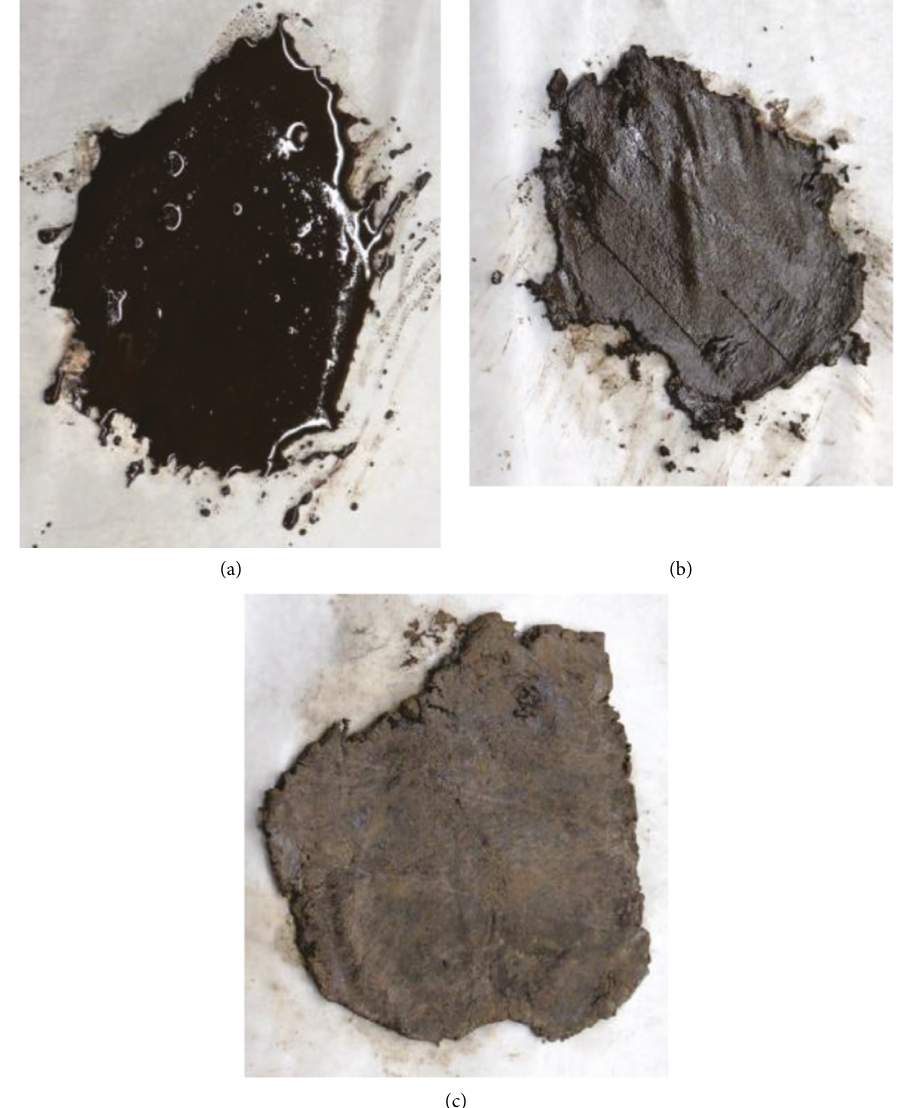
Figure 2: Evaluation of the filler concentration. (a) 20% filler content. (b) 50% filler content. (c) 70% filler content. Table 3: Mix proportions. Active—inert filler ratio by